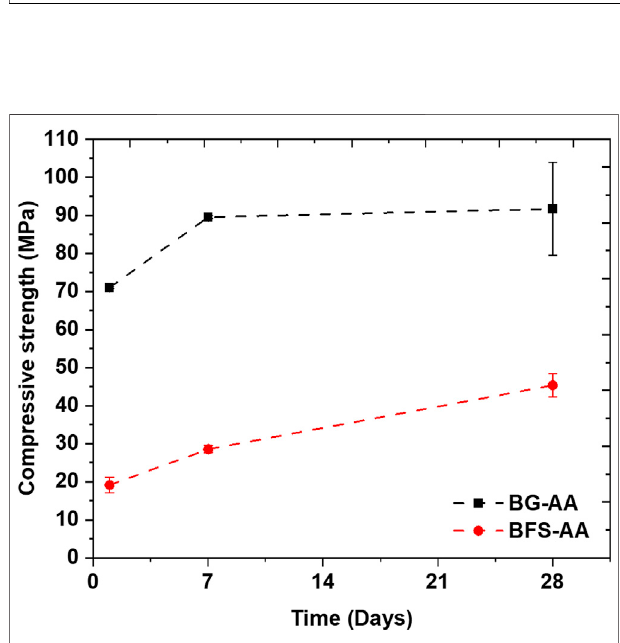
FIGURE 8 | Compressive strength of the prepared AAMs after different periods of hydration.